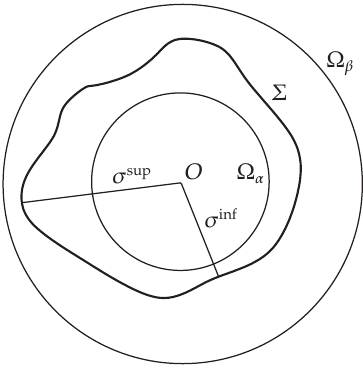
Figure 2.1 . Configuration of a regular